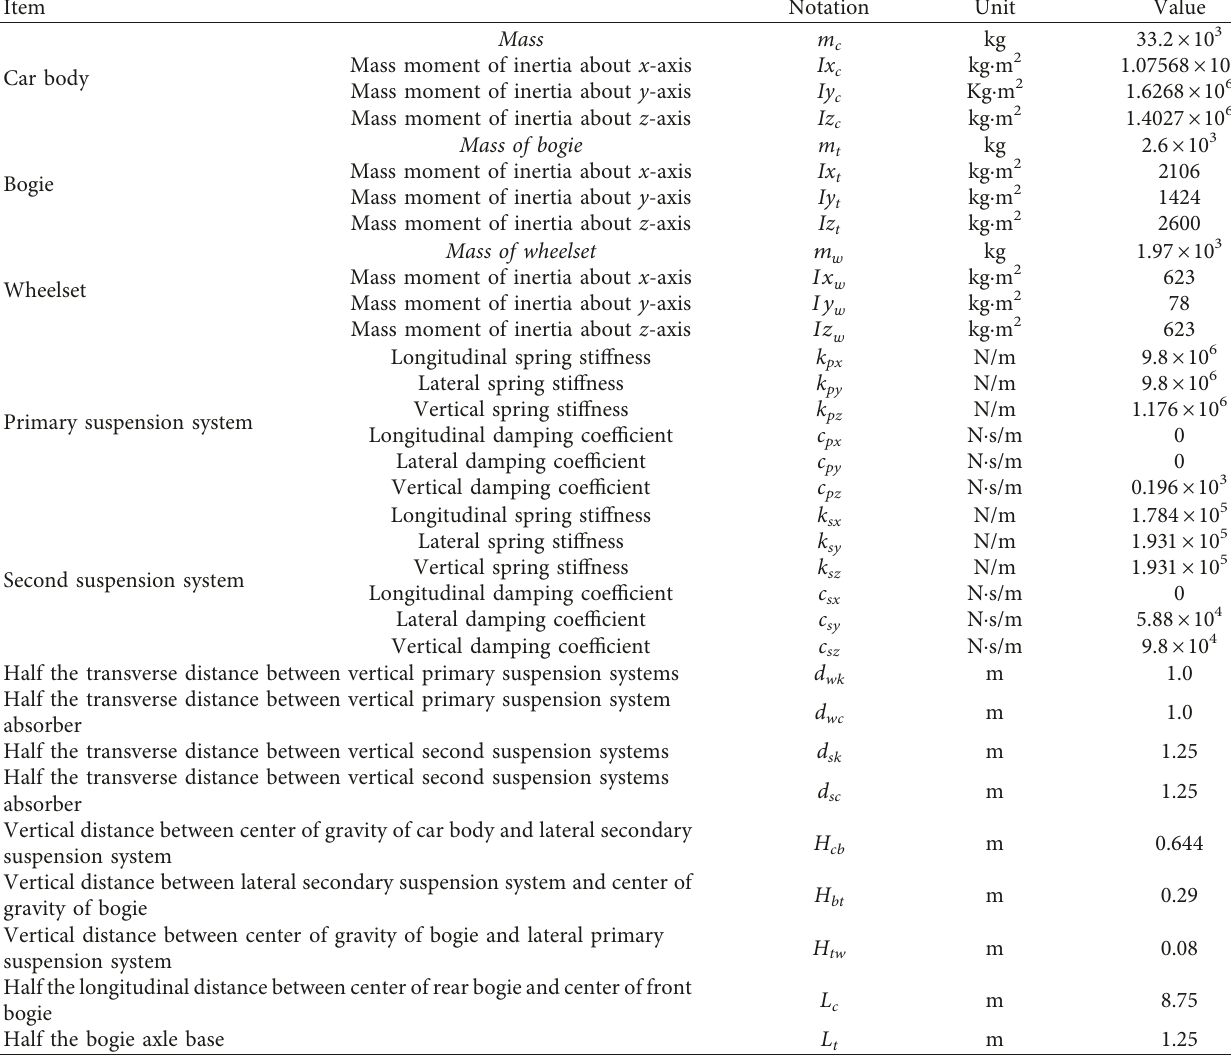
Table 2: Vehicle dynamics